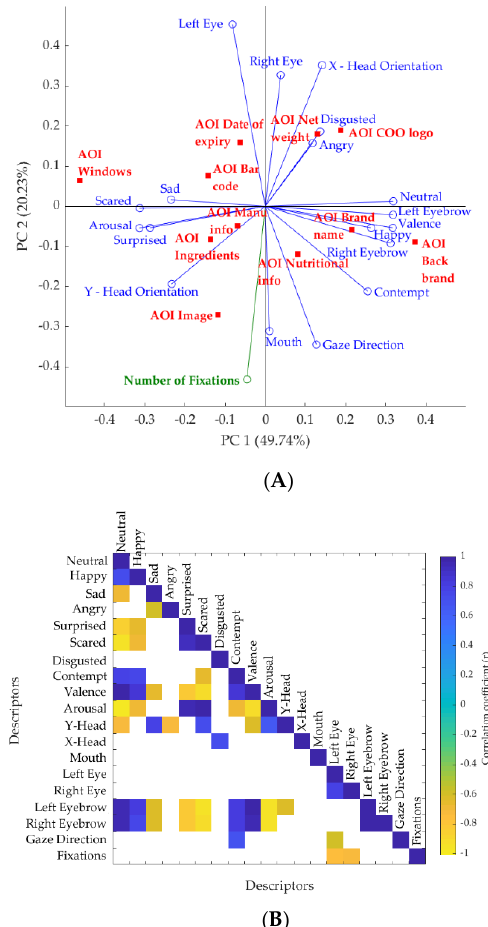
Figure 6. Results of ( A ) principal component analysis (PCA) and ( B ) correlation matrix of the FaceReader™ (FR) outputs and number of fixations from eye tracking against the area of interests (AOIs) of novel packaging concepts. Red/square: AOI, green vector: fixations from eye tracking, blue vector: FR outputs. The x-axis represents the principal component 1 (PC1), and the y-axis represents the principal component 2 (PC2) in the PCA. Abbreviations: AOI, area of interest; COO country of origin; Manu info, manufacturer’s information.